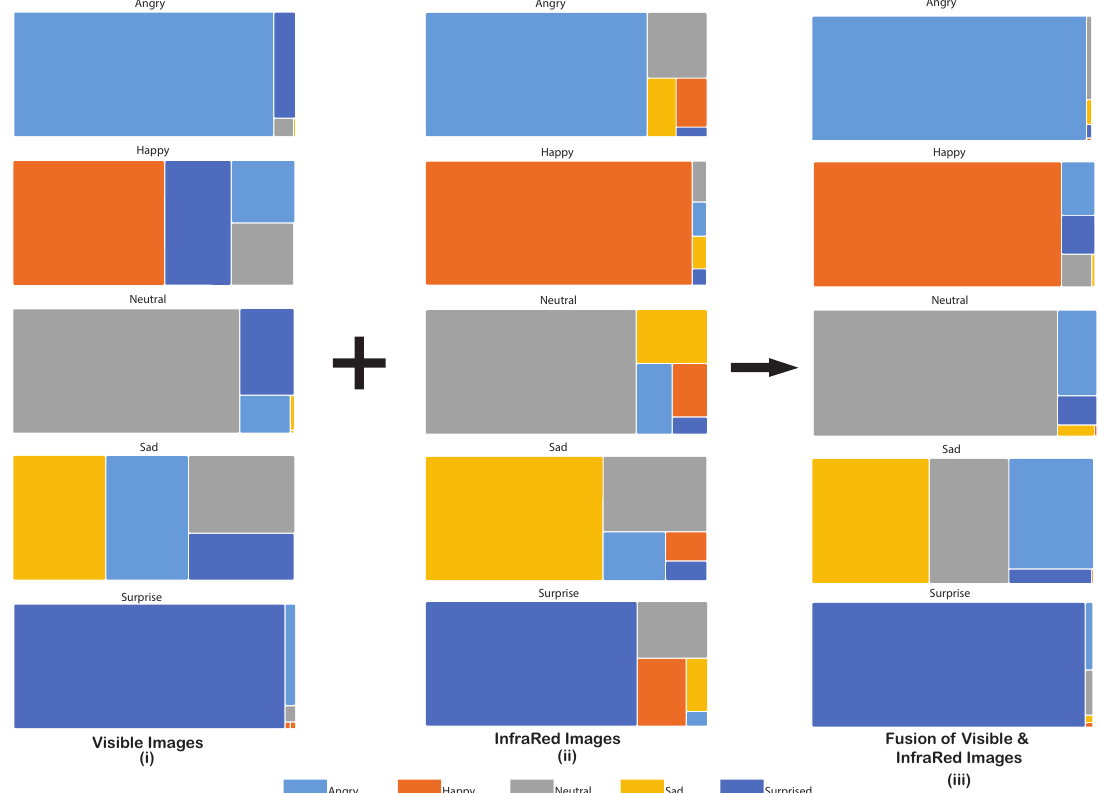
Figure 7. Treemap displaying the proportional accuracy for every detected emotion in the visible images, infrared images, and the fusion of the